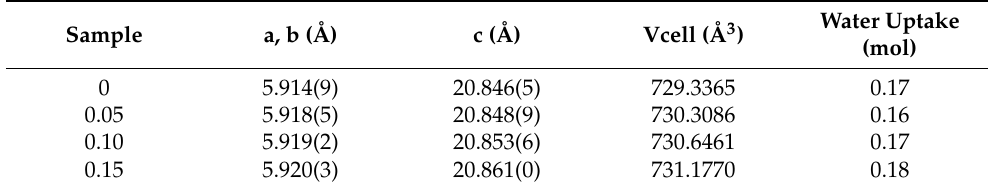
Table 1. Lattice parameters, unit cell volume and water uptake for the solid solution